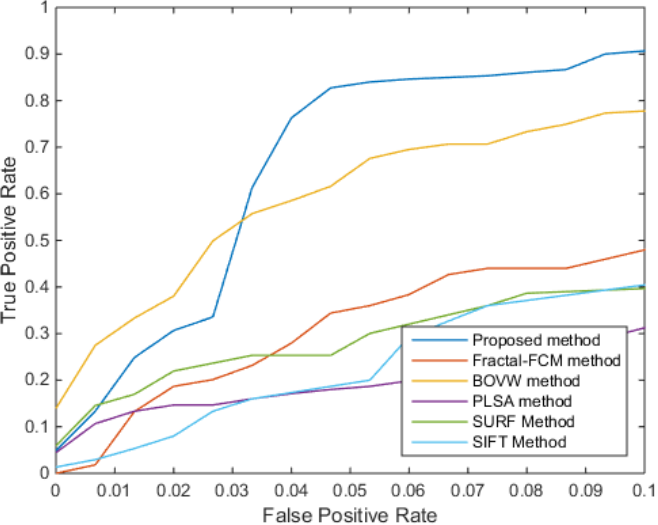
Figure 14. Partial ROC curves of the proposed method and other methods. PLSA, probabilistic latent semantic analysis.